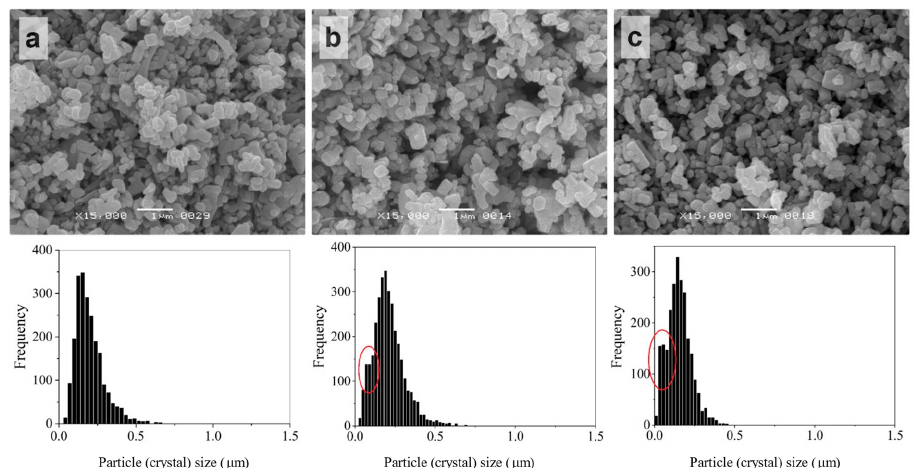
Figure 4. SEM images and crystal size distributions of ZnO powder after ZnAc introduction by impregnation: ZnO@AcZn(0.5%) ( a ), ZnO@AcZn(2.5%) ( b ), ZnO@AcZn(5%) ( c ).